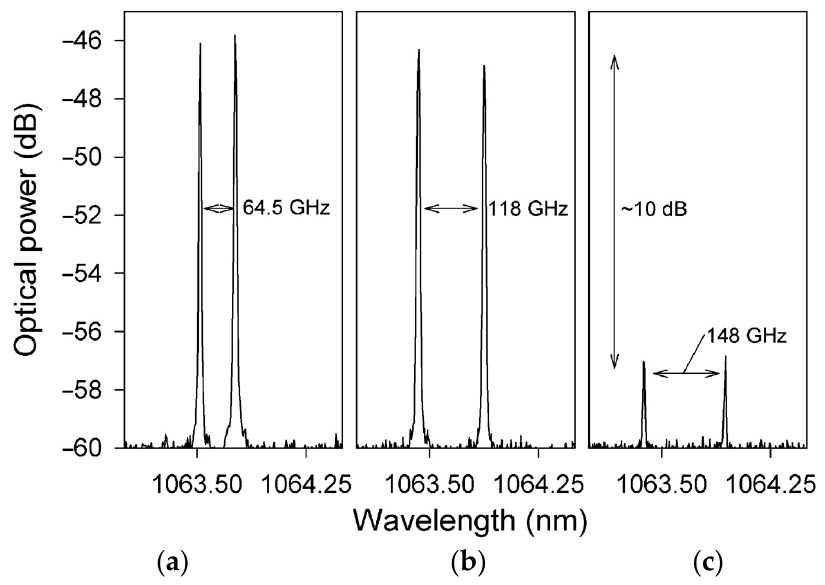
Figure 2. Oscillating spectrums of dual-frequency laser with difference frequency differences of ( a ) 64.5 GHz, ( b ) 118 GHz, and ( c ) 148 GHz [20] .